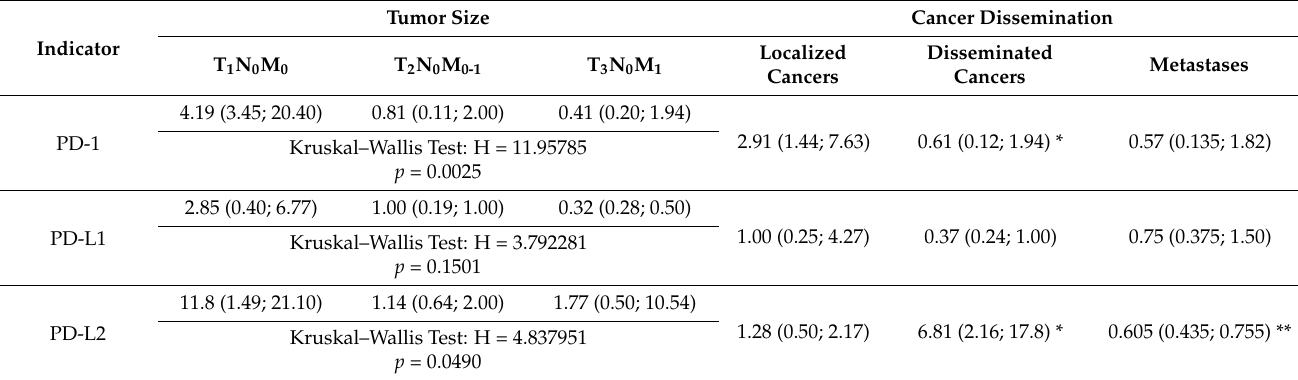
Indicator Table 1. PD, PD-L1, PD-L2 expression in ccRCC tissues depending on tumor size and disease spreading, Me (Q1; Q3). Indicator